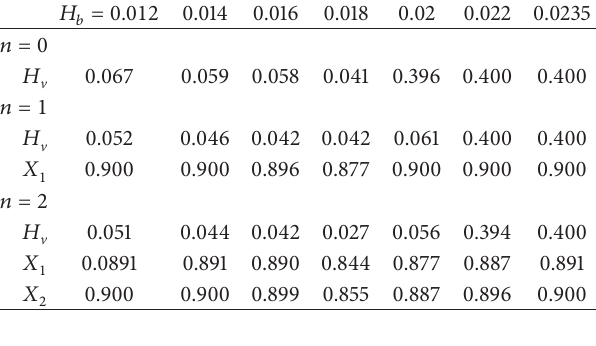
Table 4: Final values of design variables ( 𝐻 𝑏 + 𝐻 𝑐 = 0.024 ).